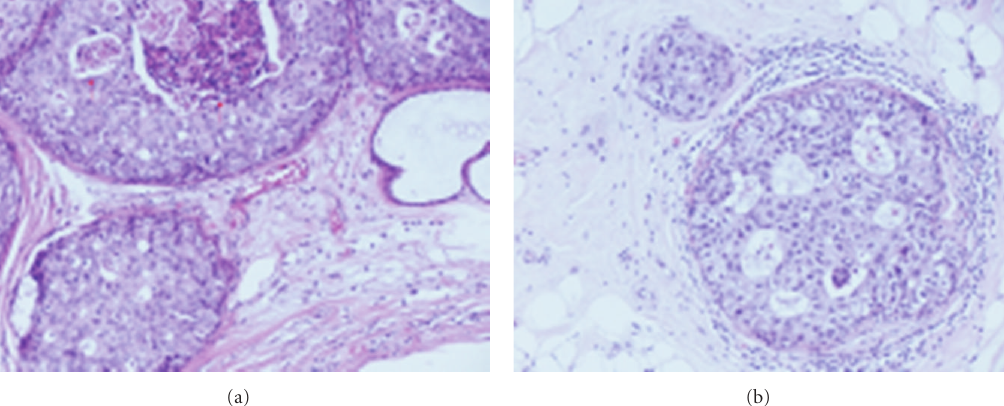
Figure 4: H.E.—intermediate grade ductal in situ carcinoma (DIN2). Obvious cribriform ductal in situ carcinoma with necrosis (Figure 4(a)— arrow ) and intermediate cytological